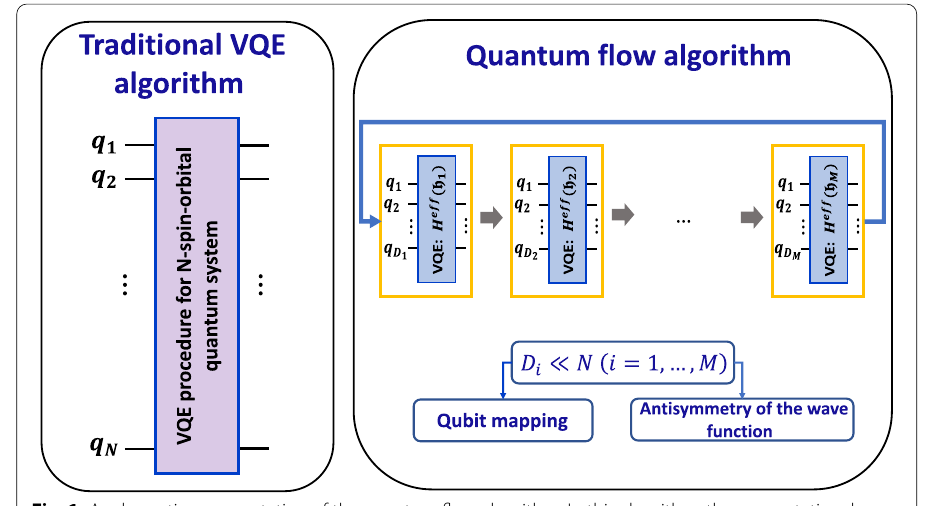
Fig. 1 A schematic representation of the quantum flow algorithm. In this algorithm, the computational problem for a large space is translated into the computational flow involving coupled eigenvalue problems involving Hermitian H eff ( h i ) ( i = 1, ... , M ) (see text for more